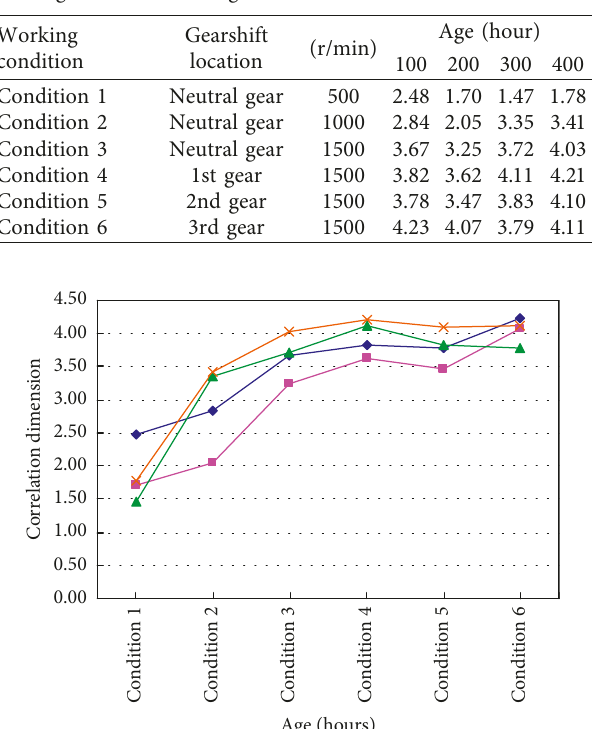
Table 1: Correlation dimensions of diesel engines at different working conditions and ages.